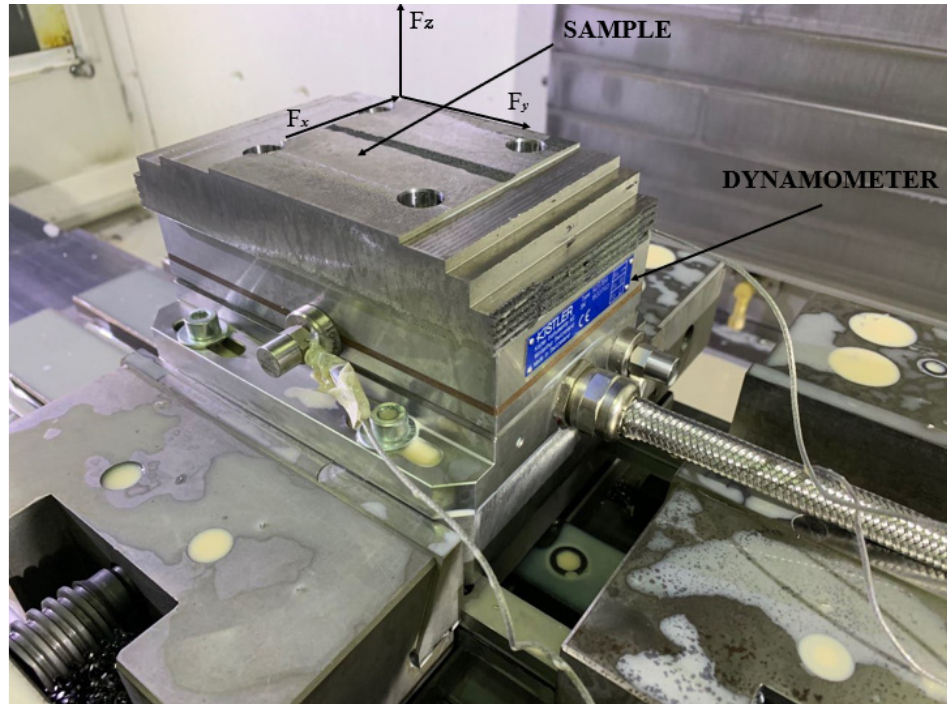
Figure 3. Workpiece clamped on the dynamometer.